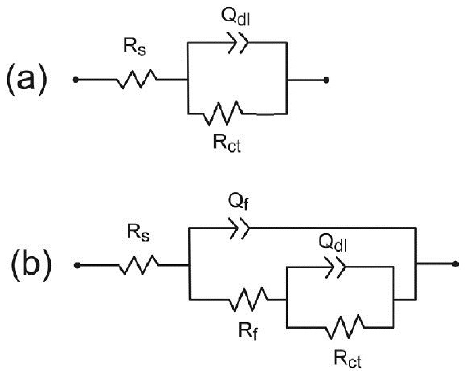
Figure 9. Equivalent circuit model for EIS measurements, a) with TTA and b) without TTA